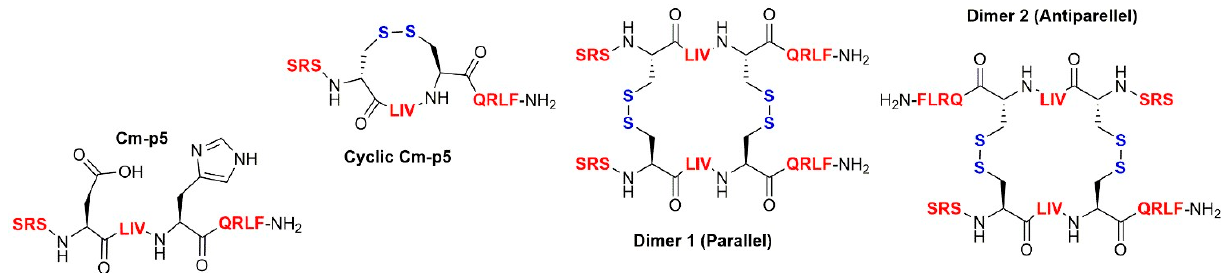
Figure 1. Structure of the designed cyclic analogues of Cm-p5.